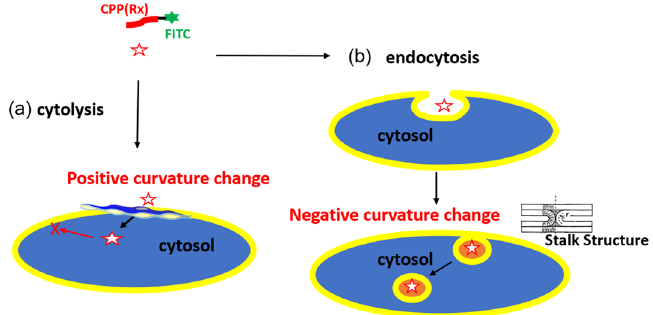
Figure 7. Schematic model of CPP permeation into cells. ( a ) Direct cytosolic (Cytolysis) internalization by positive curvature generation as local and temporal phase change to Mesh 1 , ( b ) Endocytic internalization (Endocytosis) by negative curvature generation through Stalk structure. Under the Cytolysis mechanism shown here, internalized CPP would not leak out because inner lipid membrane has negative curvature and oppose for the phase change to Mesh 1